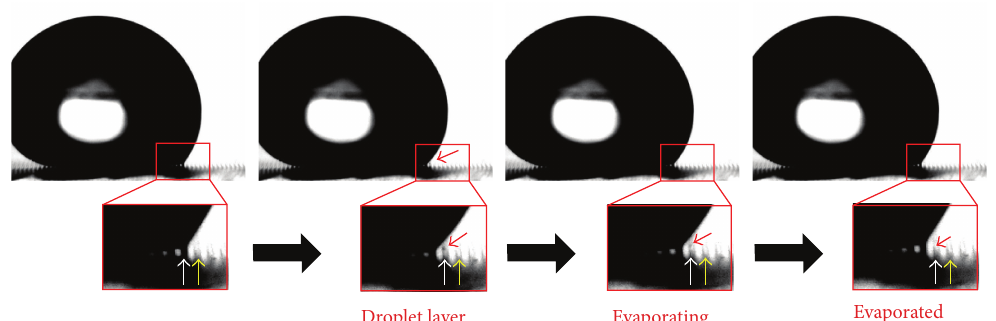
Figure 5: Droplet layer left behind a sliding droplet.